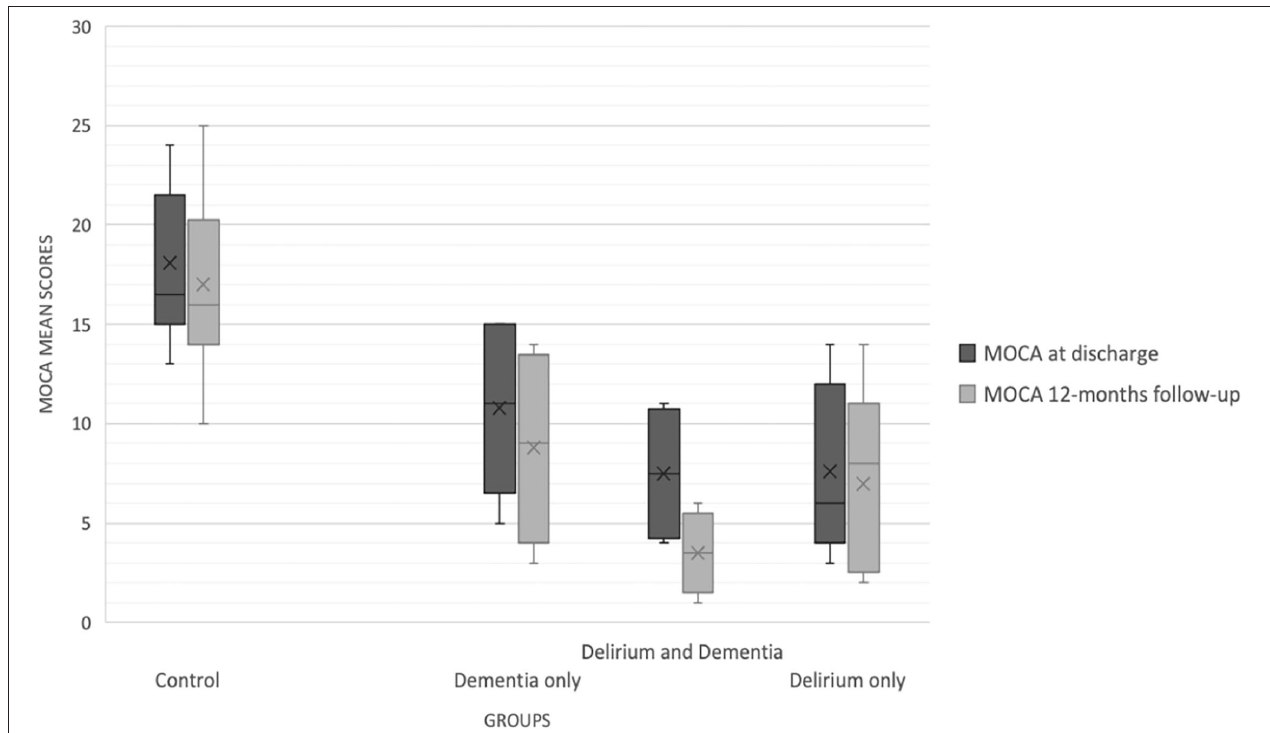
FIGURE 2 | MoCA scores during hospitalization and at 12-months